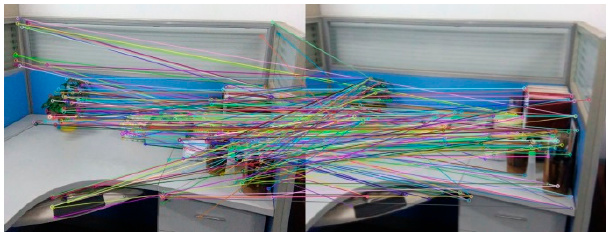
Figure 10. Image A registered with its own after blurring.